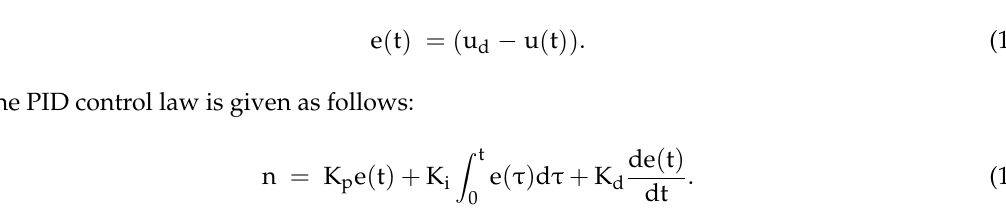
Table 4. The parameters of heading controller.